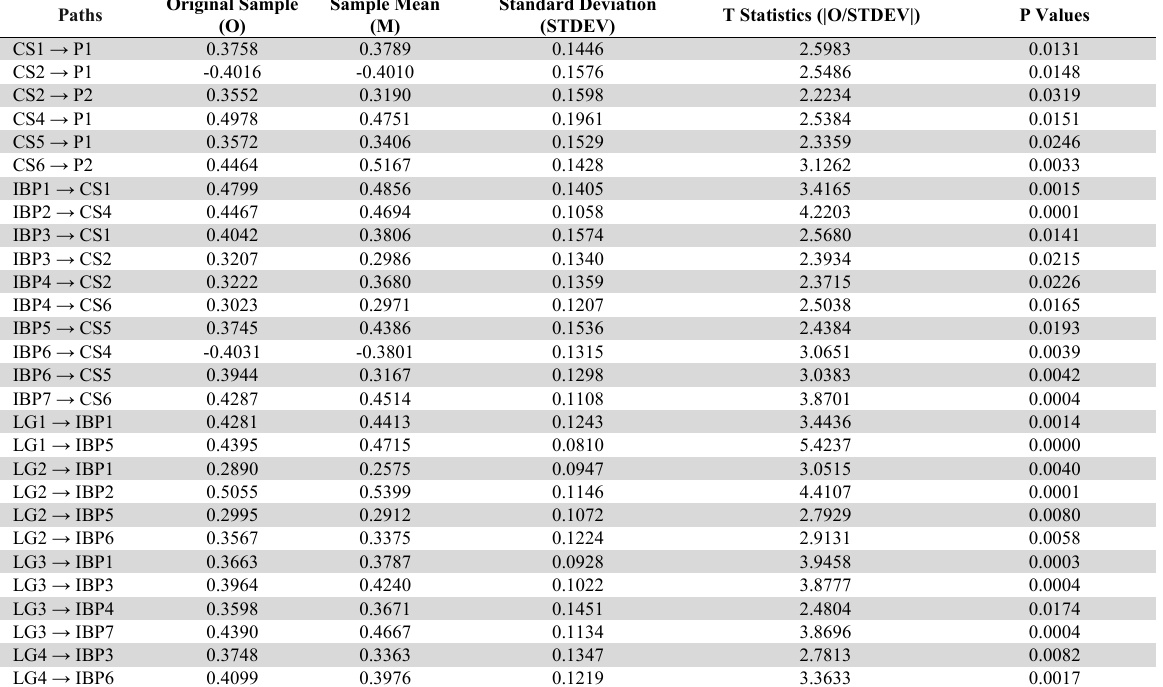
Hypothesis Test Model